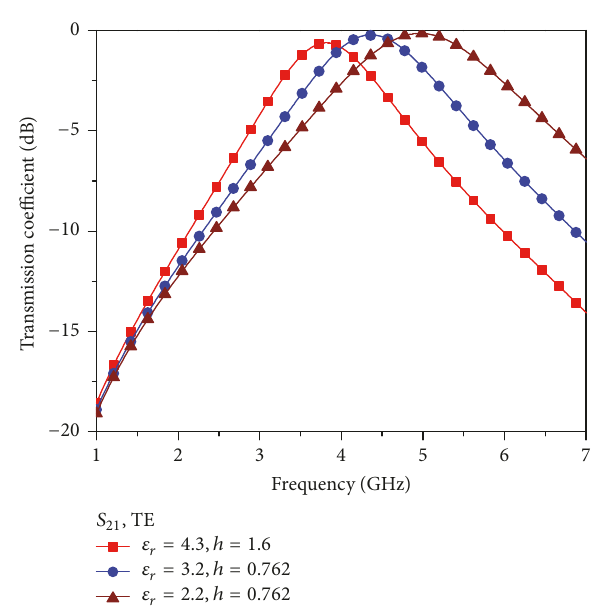
Figure 3: FSS characteristics of the unit cell for TE mode of polarization at different dielectric constant ( 𝜀 𝑟 ) and thickness ( ℎ